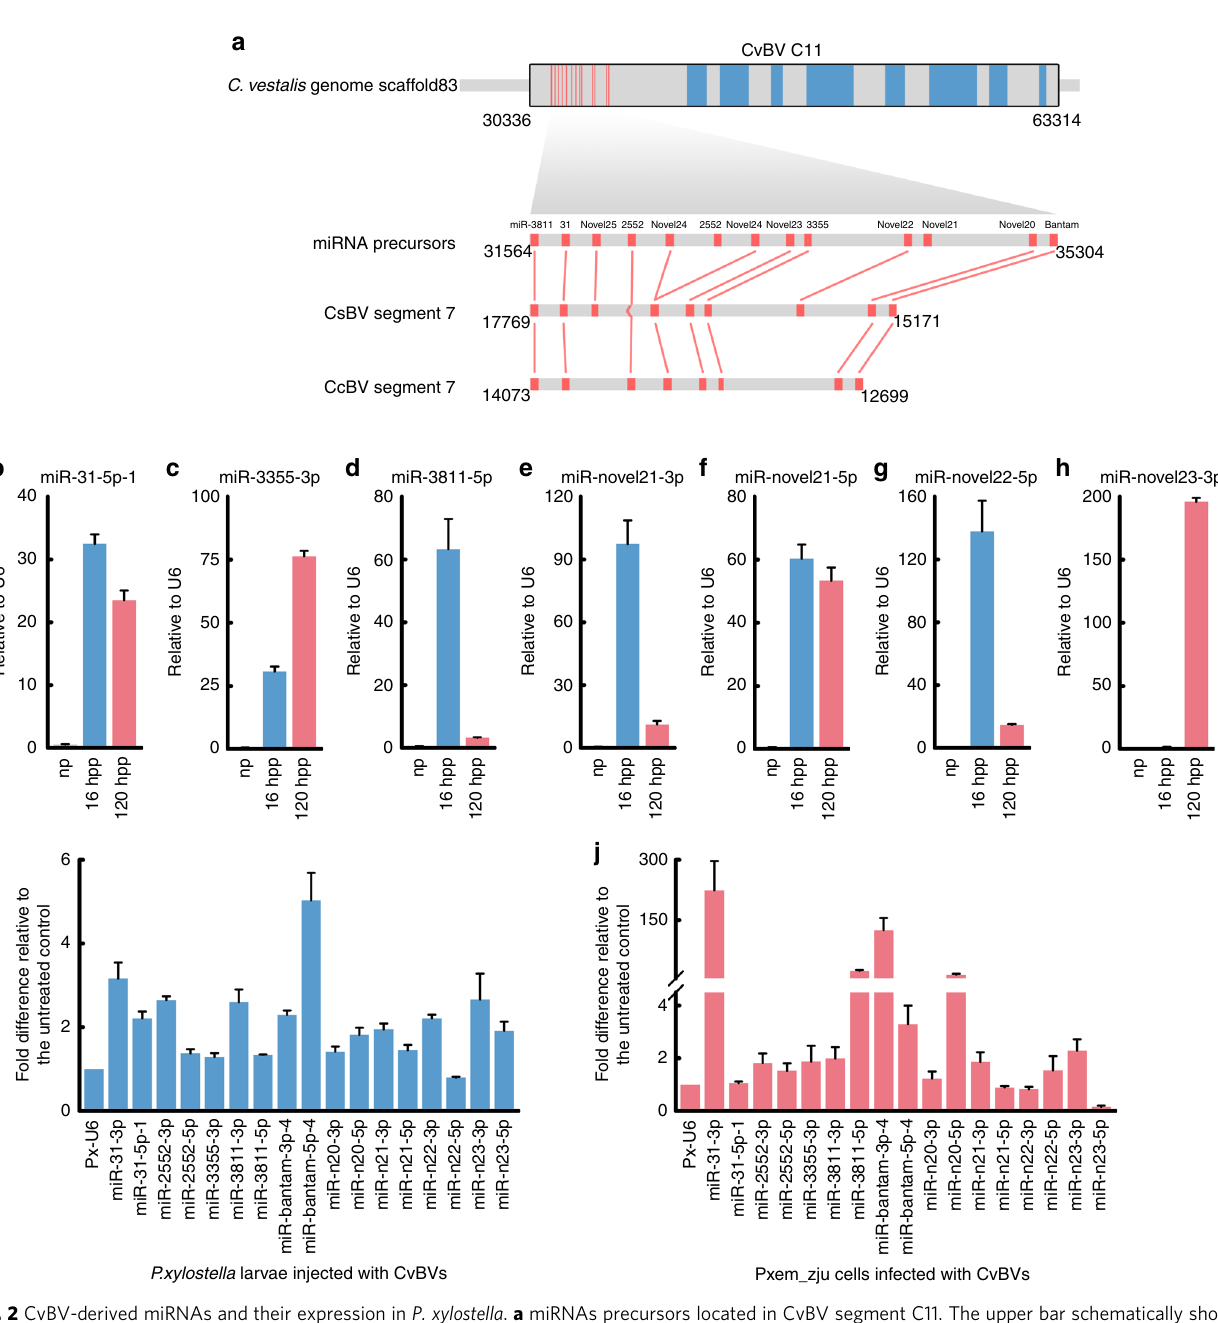
Fig. 2 CvBV-derived miRNAs and their expression in P. xylostella . a miRNAs precursors located in CvBV segment C11. The upper bar schematically shows segment C11 in C. vestalis genome scaffold 83. Red vertical lines represent miRNA precursors while blue vertical bars identify predicted protein coding sequences. Below the upper bar is shown the domain of segment C11 that encodes miRNA precursors together with schematics showing miRNA precursors identi fi ed in CsBV segment 7 and CcBV segment 7 (Results). b – h RT-qPCR analysis of eight CvBV-derived miRNAs in P. xylostella normalized to P. xylostella U6 snRNA. np: non-parasitized P. xylostella , hpp: hours post parasitized. Ct values for undetected samples are considered as 40. i RT-qPCR analysis of 17 CvBV-encoded miRNAs in P. xylostella larvae injected 24 h earlier with 0.1 FEs of CvBV particles. P. xylostella were injected during third instars. Relative expression of CvBV-encoded miRNAs was normalized to the P. xylostella U6 snRNA. j RT-qPCR analysis of 17 CvBV-encoded miRNAs in Pxem-ZJU cells (5 × 10 6 cells) 24 h post infection with 20 FEs of CvBV particles. The expression of CvBV-encoded miRNAs was normalized to P. xylostella U6 snRNA. Results shown are mean relative abundance ± s.e.m. of each miRNA from three independent biological replicates